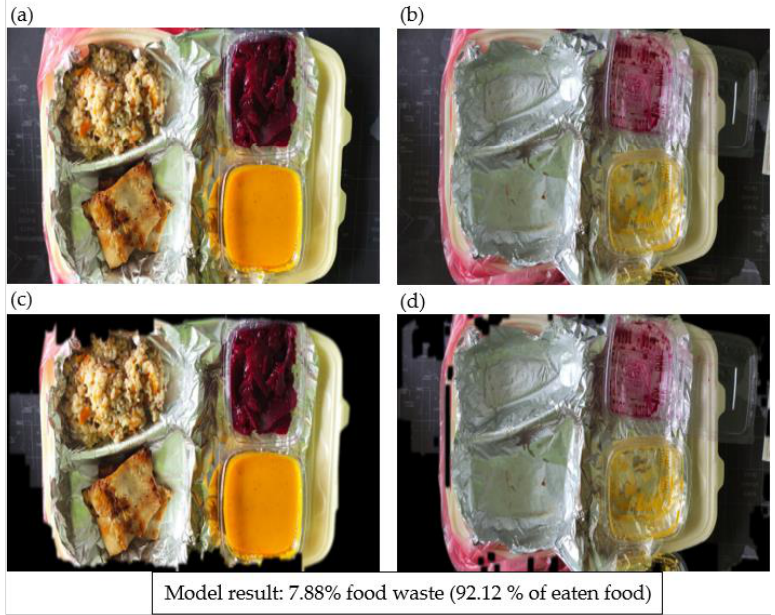
Figure 5. The example of images in plastic boxes ( a ) before the meal, ( b ) after the meal, ( c ) before the meal and masked and ( d ) after the meal and masked.